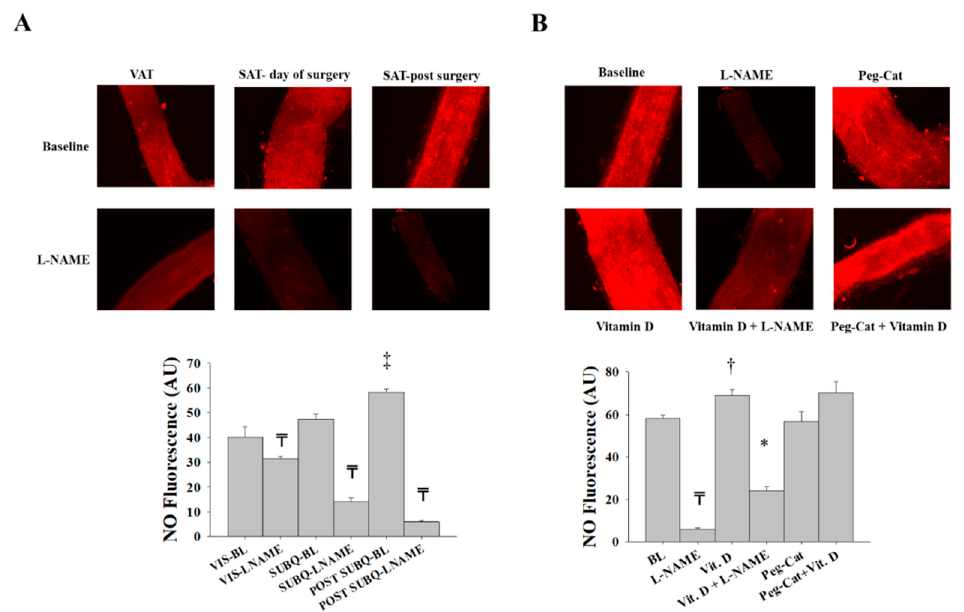
Figure 10. NO production in isolated adipose tissue arterioles. ( A ) Representative images by fluorescence microscopy of NO generation conditions at baseline and after incubation with L-NAME in adipose tissue arterioles collected on the day of surgery (VAT and SAT day of surgery) and three months after surgery (SAT post-surgery). ( B ) Representative fluorescence microscopy images of NO generation conditions at baseline and after incubation with L-NAME, PEG-CAT, vitamin D, vitamin D plus L-NAME, and vitamin D plus PEG-CAT in SAT arterioles collected three months after surgery. Charts represent NO fluorescent signals that were measured and expressed in arbitrary units using NIH Image J software. All measures are represented as means ± SE; ₸ p < 0.05 comparing L-NAME with corresponding baseline in VAT, SAT day of surgery, and SAT post-surgery, ‡ p < 0.05 comparing SAT day of surgery and SAT post-surgery, † p < 0.05 comparing vitamin D with baseline, and * p < 0.05 comparing L-NAME + vitamin D with vitamin D alone.